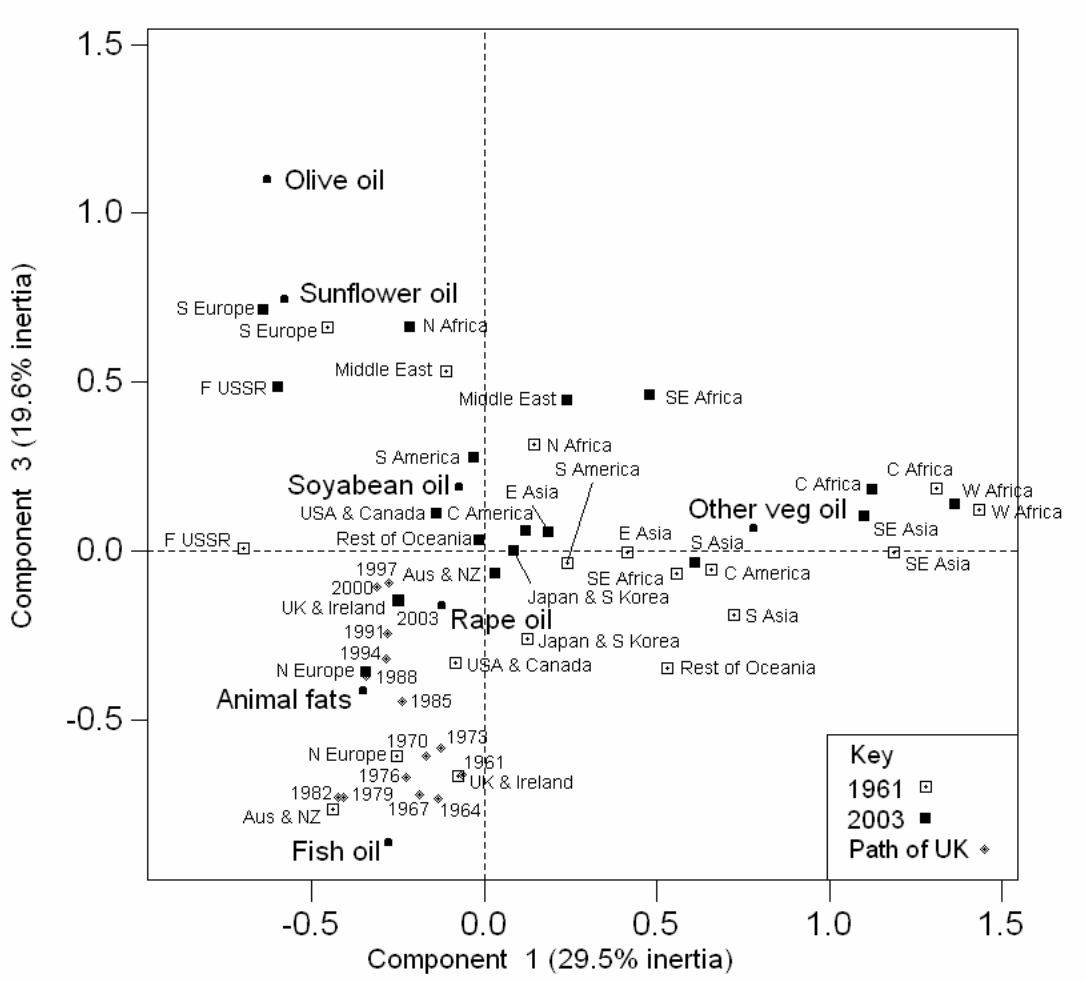
Figure 2: Correspondence analysis – the availability of simplified edible lipid categories by world region in 1961 and